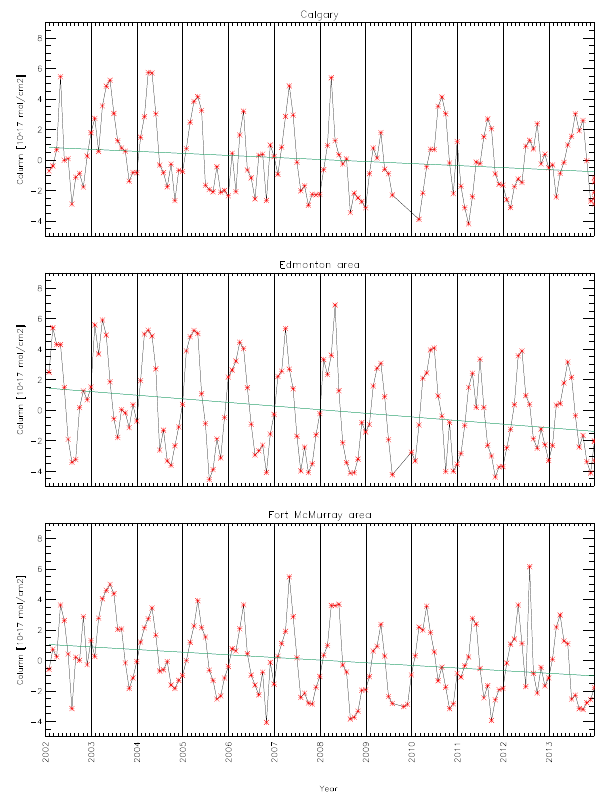
Figure 8. The 12-year interannual variations in monthly averaged daytime MOPITT CO total column measurements for the period January 2002 to December 2013 over the Calgary, Edmonton, and Fort McMurray areas.